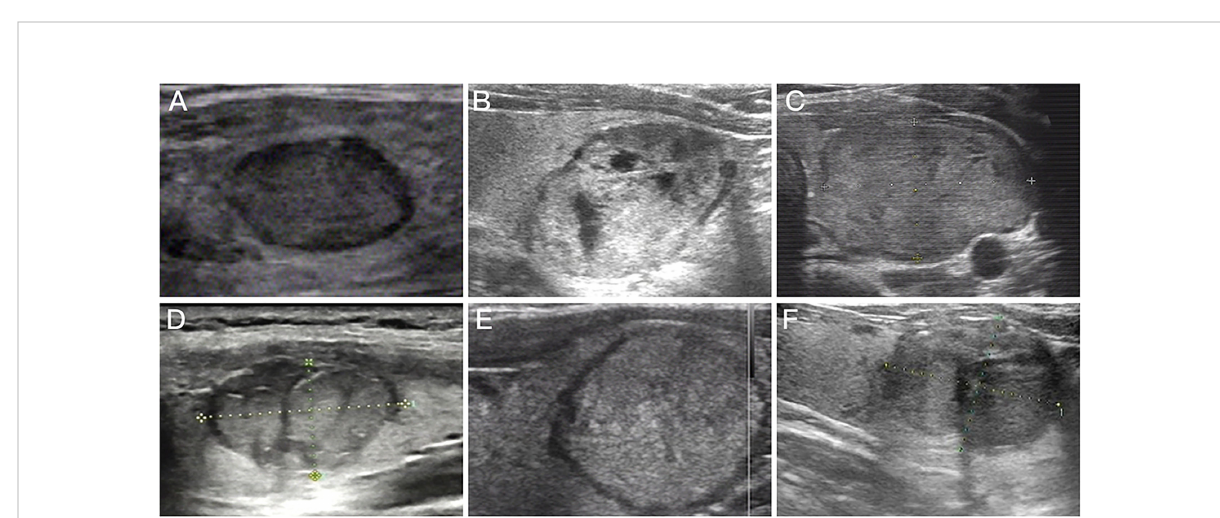
FIGURE 2 Preoperative ultrasound images for follicular thyroid adenoma and follicular thyroid carcinoma. (A) Preoperative ultrasound image of nodule with regular margin diagnosed as follicular thyroid adenoma; (B) Mixed nodule that postoperative pathological diagnosis was follicular thyroid adenoma; (C) Preoperative ultrasound image of isoechoic nodule diagnosed as follicular thyroid adenoma; (D) Preoperative ultrasound image of nodule with irregular margin diagnosed as follicular thyroid carcinoma; (E) Purely solid nodule that postoperative pathological diagnosis was follicular thyroid carcinoma; (F) Preoperative ultrasound image of hypoechoic nodule diagnosed as follicular thyroid carcinoma.